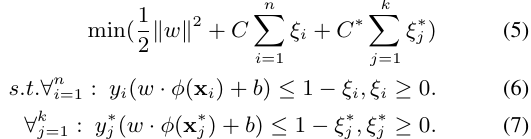
Figure 4: Different characteristics with respect to different types of changes. (c)distributions of change features in Euclidean coor- dinates. (d)distributions of change features in polar